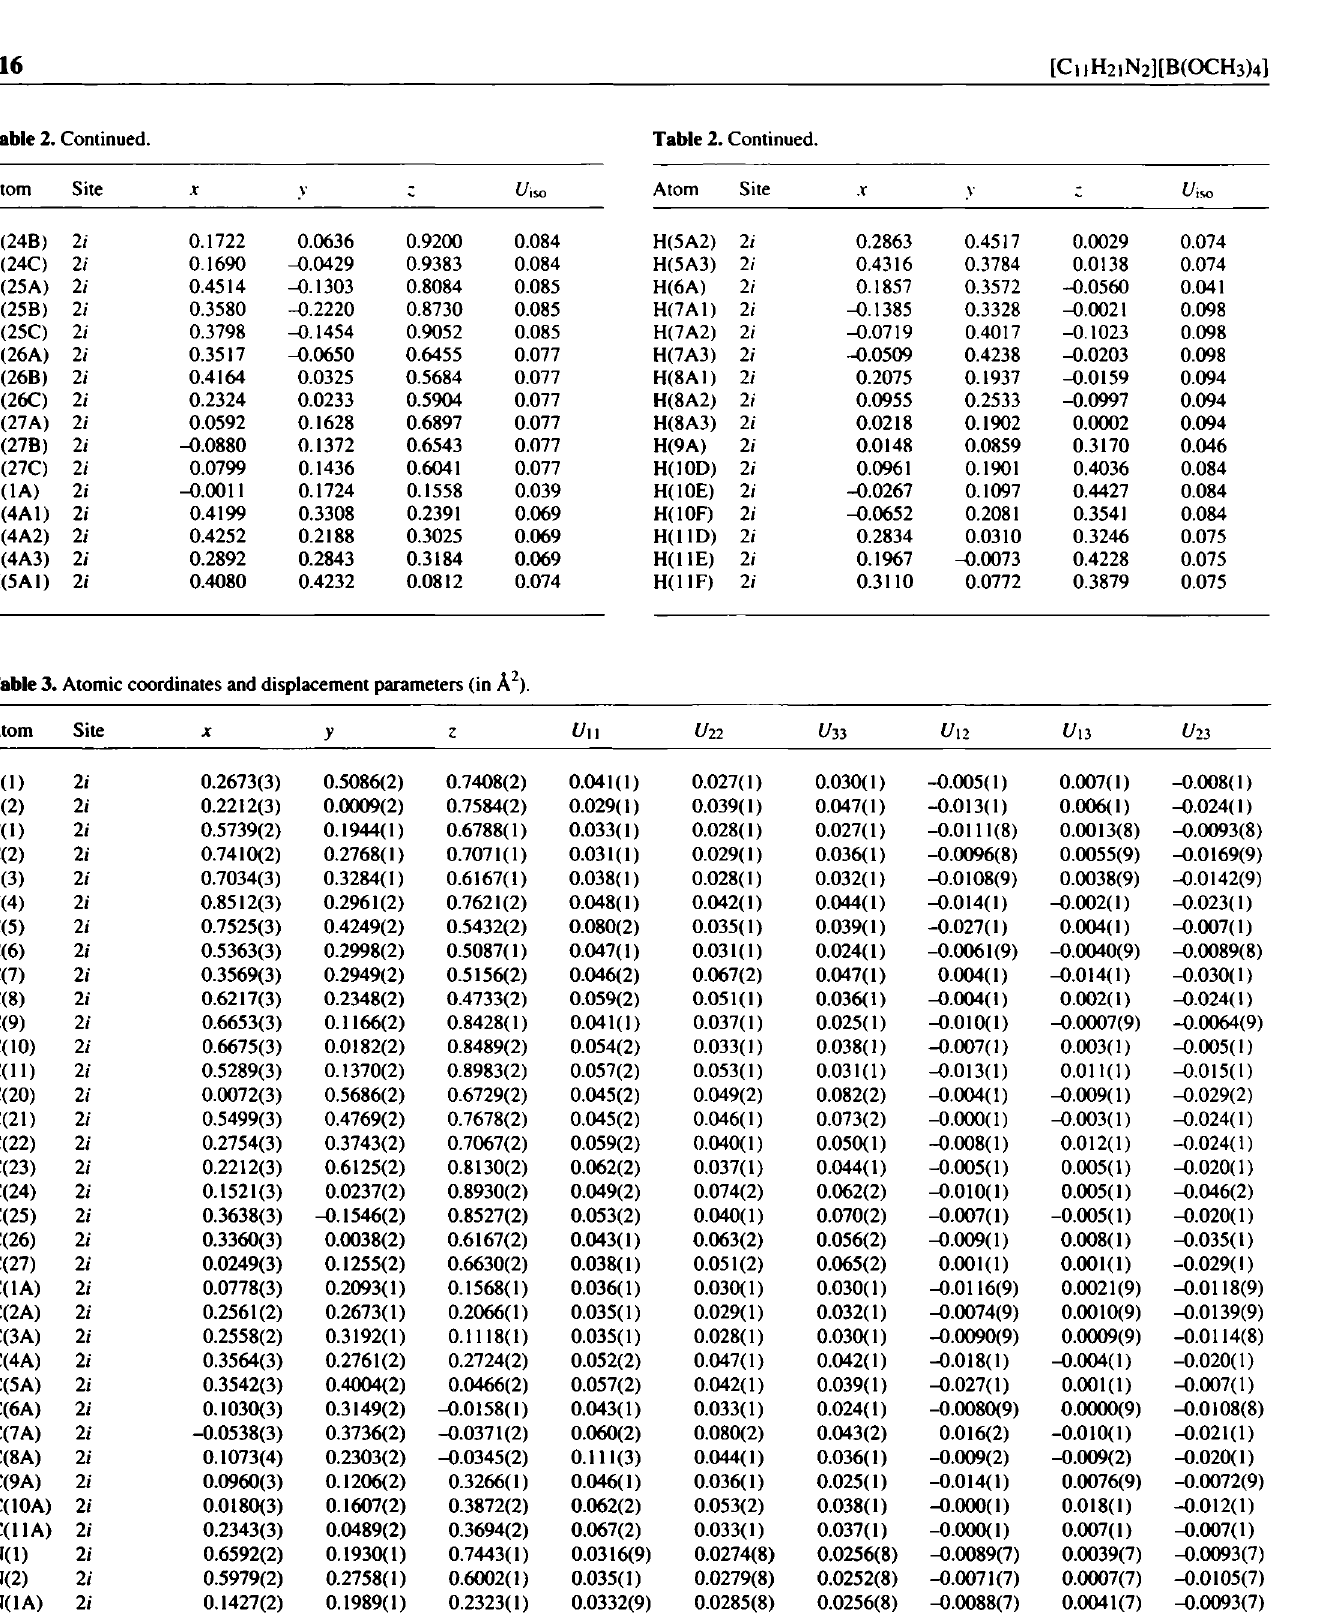
Table 3. Atomic coordinates and displacement parameters (in Ä 2